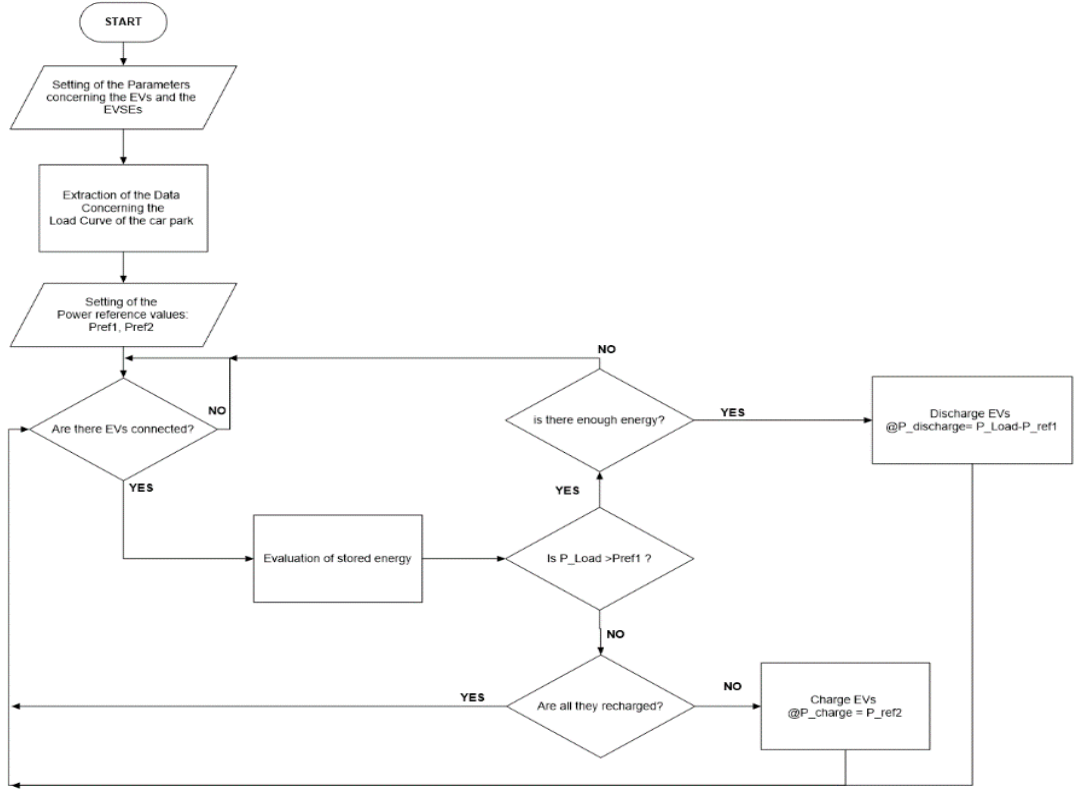
Figure 22. Flowchart of the “peak shaving” algorithm.